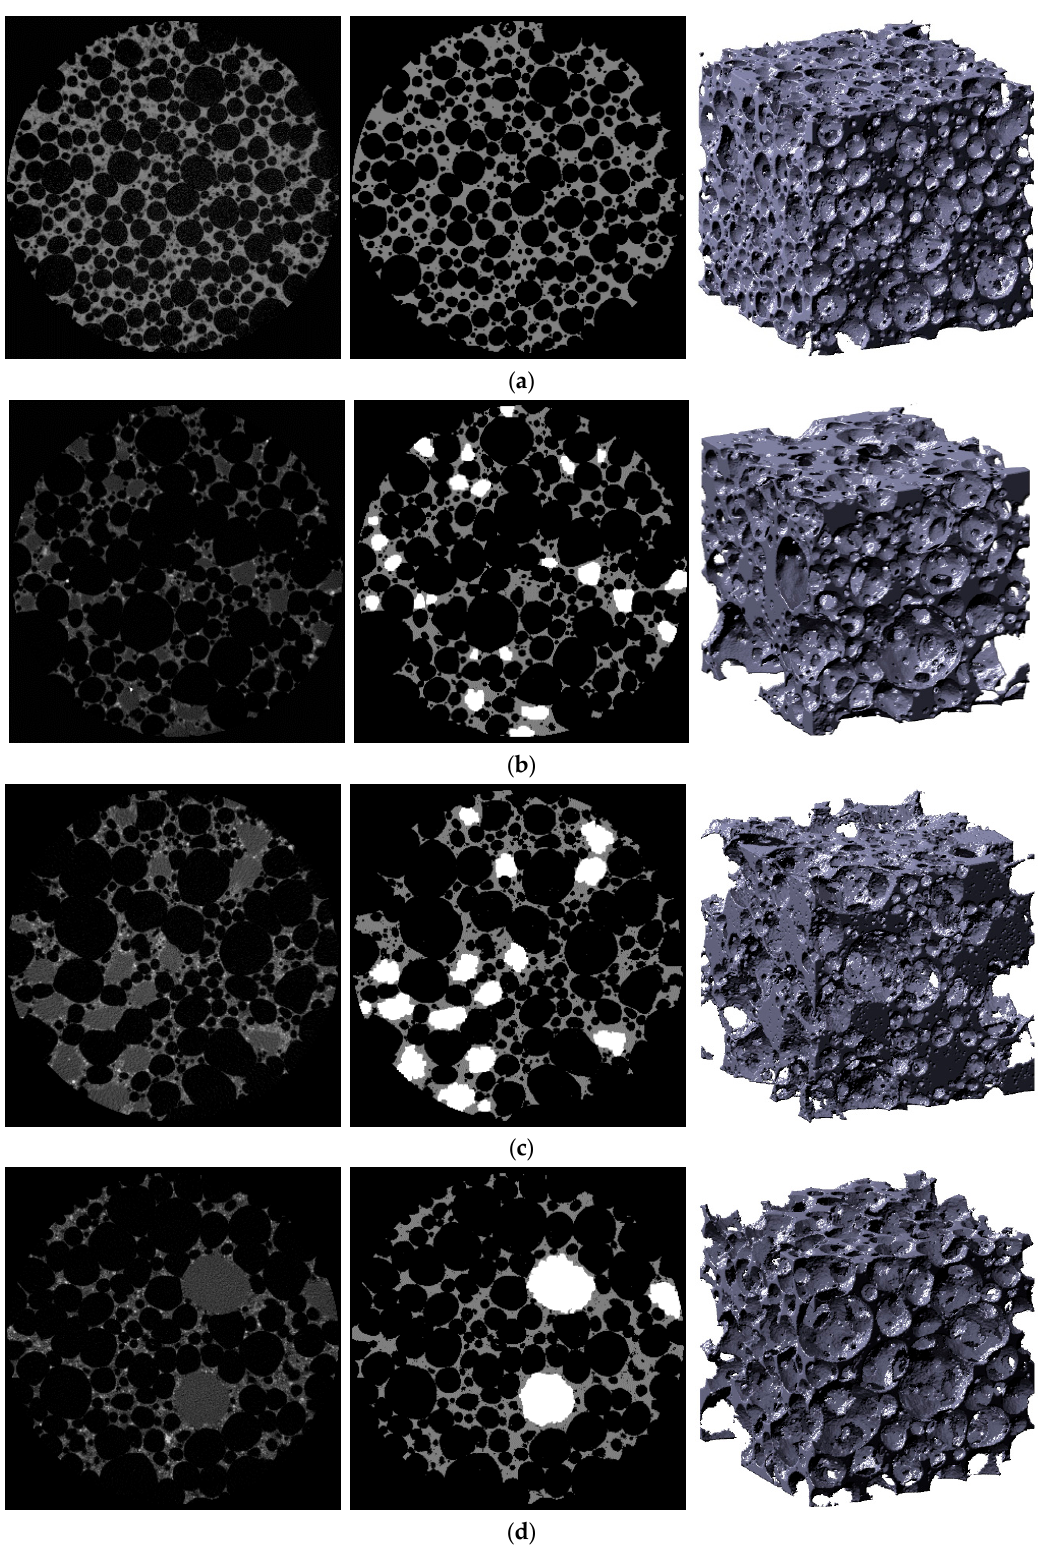
Figure 4. A representative micro-CT scan, corresponding phase segmentation, and 3D reconstruction of samples ( a ) Control, ( b ) 0.5_300 µm, ( c ) 0.5_600 µm, and ( d ) 0.5_850 µm, where the micro-CT scan has a side length of 5000 µm and the 3D reconstruction has a side length of 2500 µm.